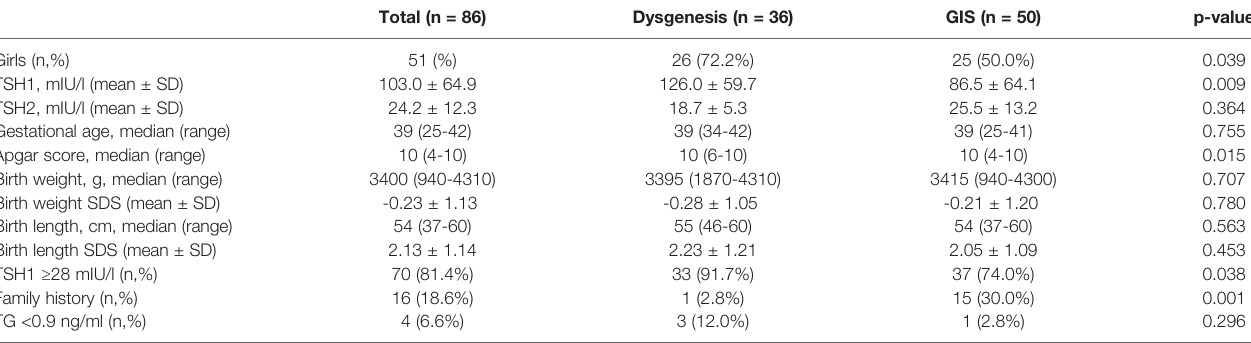
TABLE 2 | Ultrasonography evaluation in the examined group.